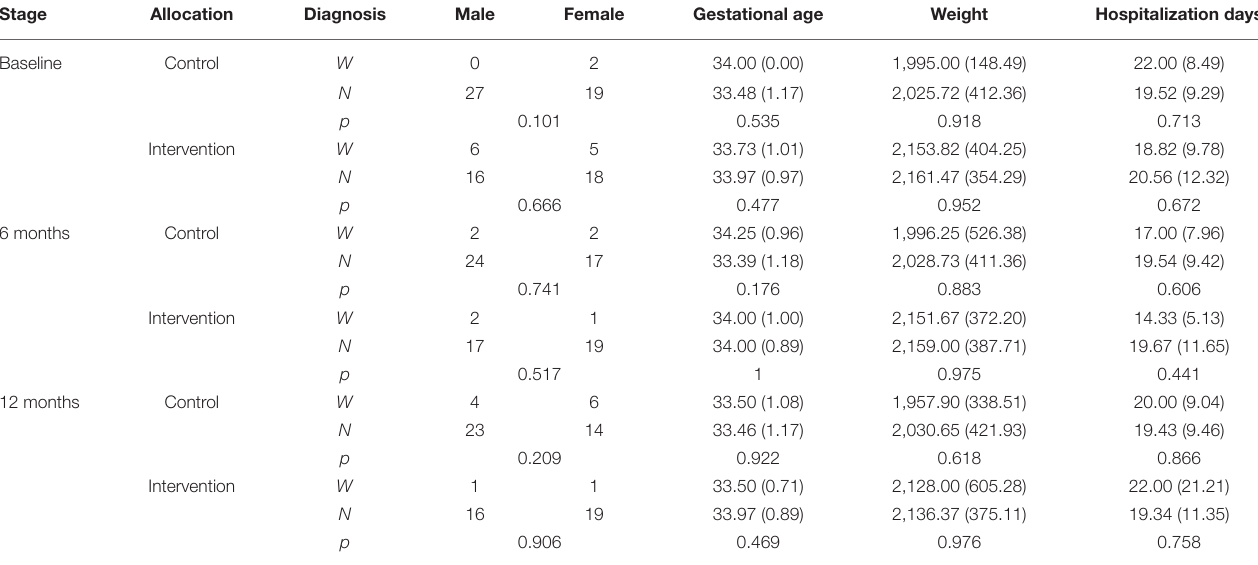
TABLE 3 | Comparison of infants with and without SSW depending on stage and allocation.